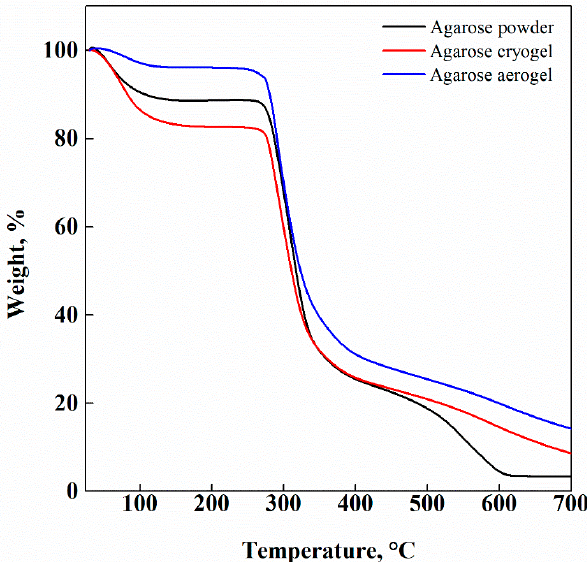
Figure 7. TGA of untreated agarose powder (black line), agarose cryogel (red line) and agarose aerogel (blue line).